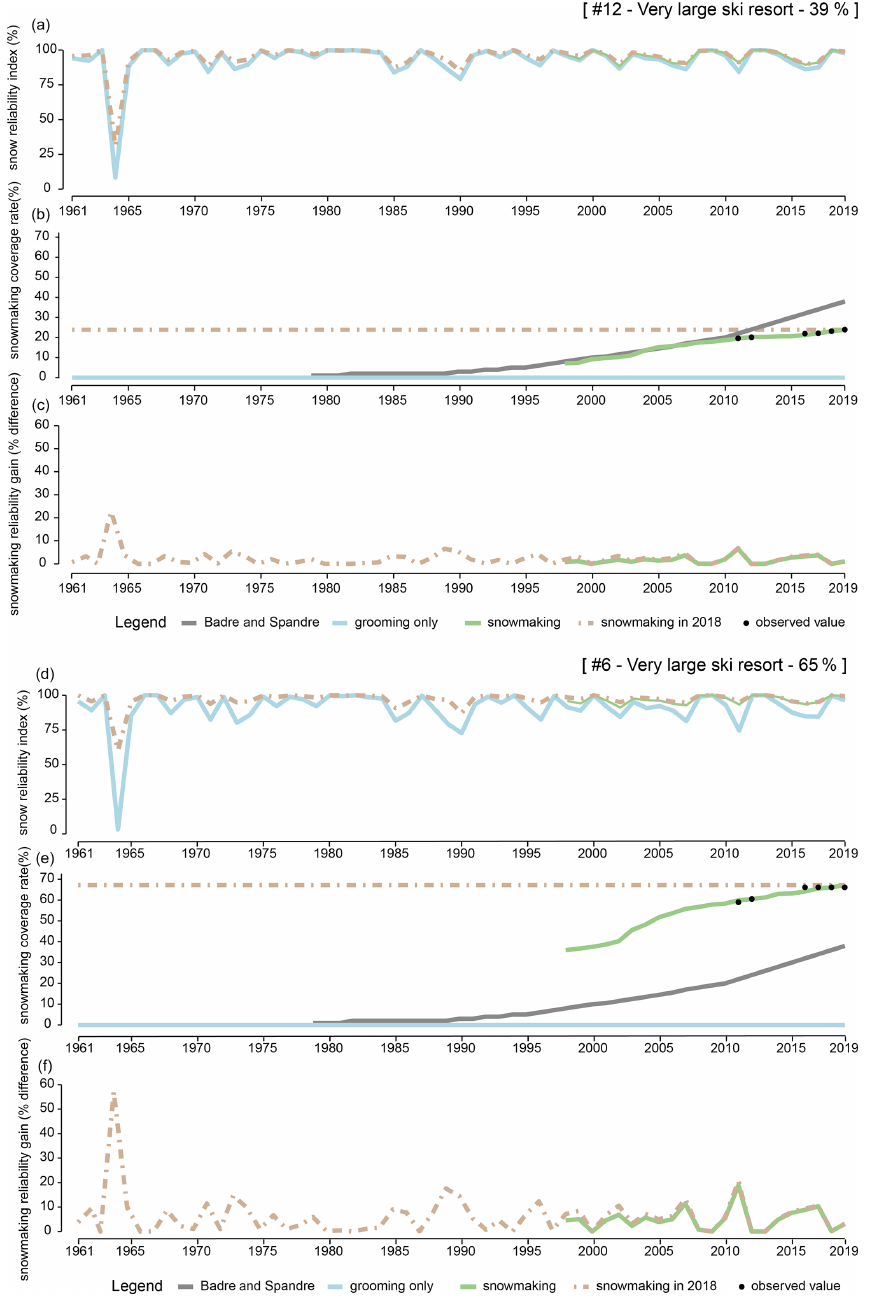
Figure 3. Time evolution of the combined snow reliability indicator and snowmaking fractional coverage for two contrasting very large ski resorts (ski resort no. 6 has 65% of its ski area and ski resort no. 12 has 39% of its ski area below 2000m) in Savoie from 1961 to 2019. Panels (a) and (d) represent the time variations in the indicator for several snow management options (grooming only, snowmaking coverage corresponding to Badré et al., 2009 – mean value for all French ski resorts, individual evolution of the snowmaking coverage based on investment figures and situation corresponding to using the snowmaking coverage in 2018 for the whole time period). Panels (b) and (e) indicate the corresponding snowmaking fractional coverage. Panels (c) and (f) represent the increase in snow cover reliability compared to the grooming-only situation. Ski resort no. 6 shows a higher-than-average snowmaking equipment value, while ski resort no. 12 shows a lower-than-average snowmaking equipment